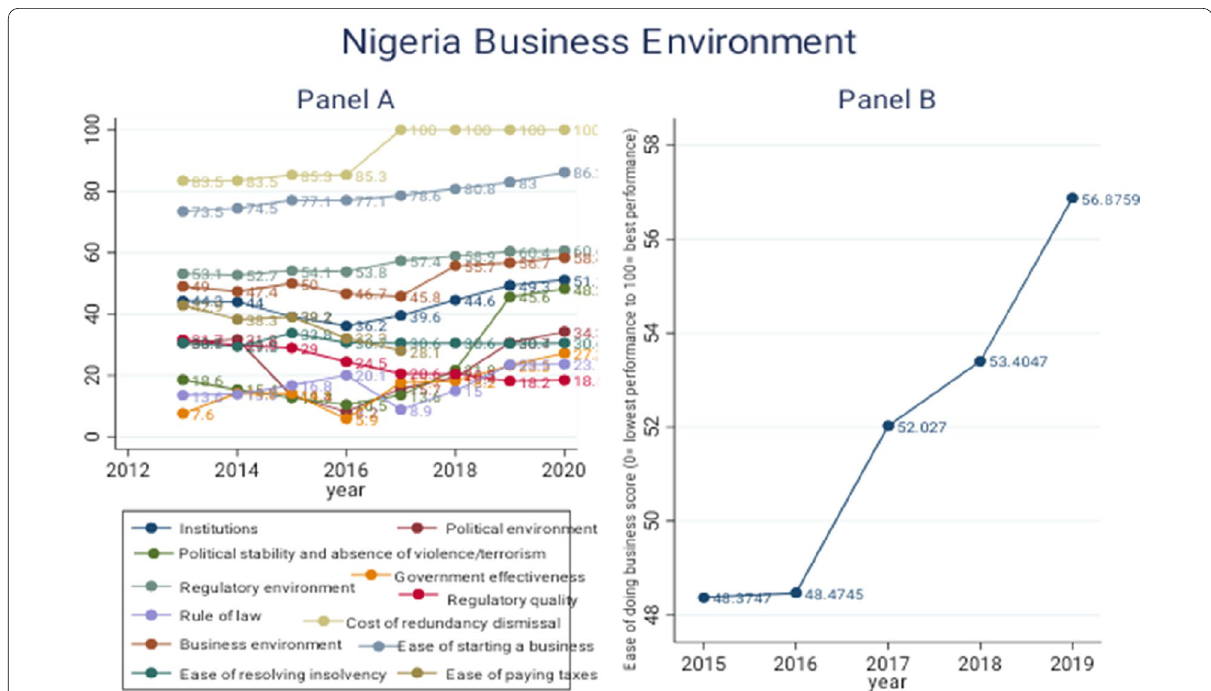
Fig. 1 Nigeria’s business environment. Source: Author’s Computation using Data from Global Innovation Index and World Development